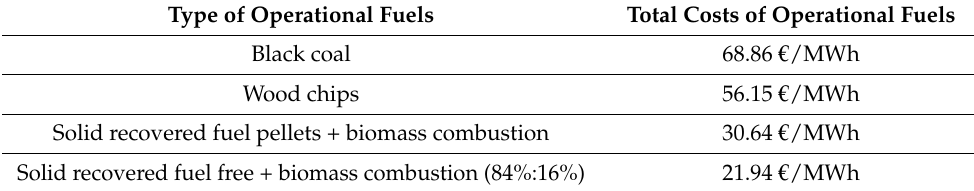
Table 5. Conversion of operating fuel